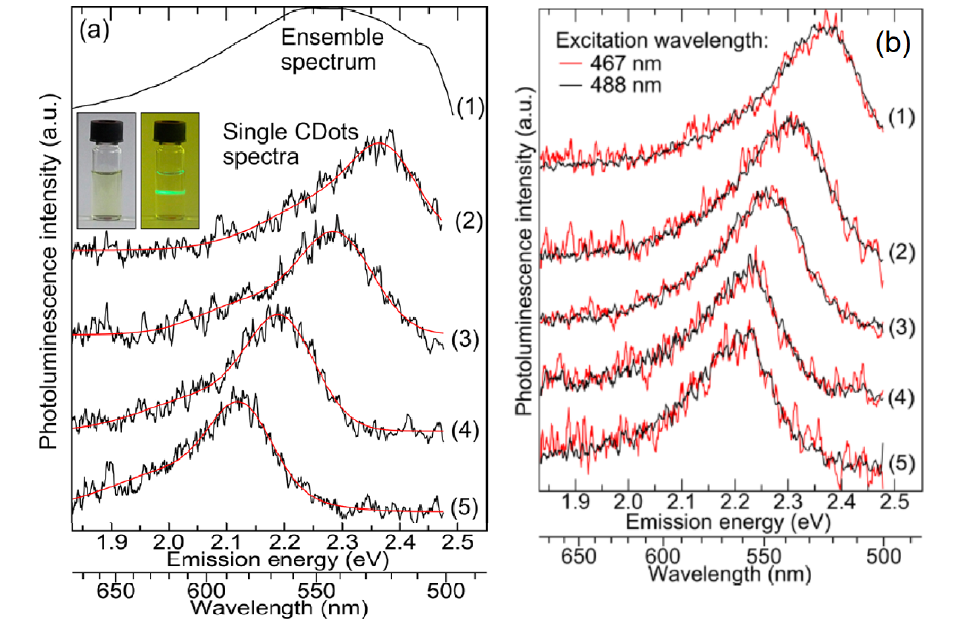
Figure 8. ( a ) (1): Ensemble emission spectrum excited at 488 nm; (2)–(5): emission spectra from individual dots excited at 488 nm; ( b ) (1)–(5) emission spectra from individual dots excited at 467 nm (red curves) and at 488 nm (black curves). Reproduced with permission from [191]. Copyright American Chemical Society,